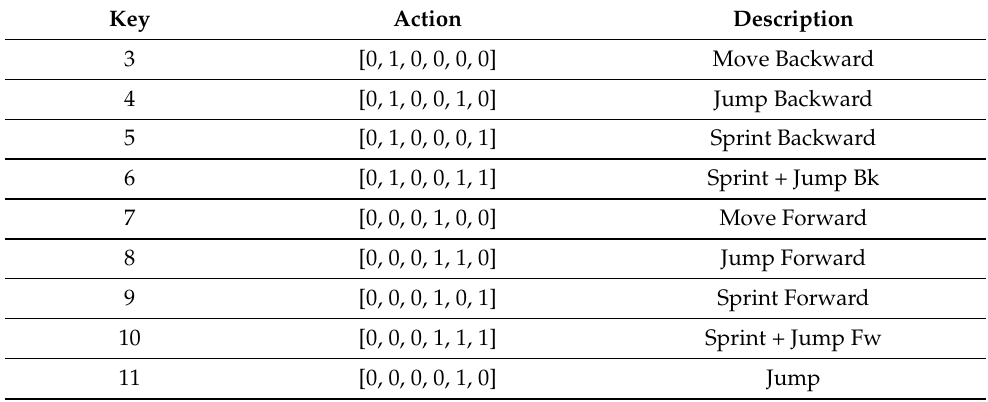
Table 2. Discrete action space with